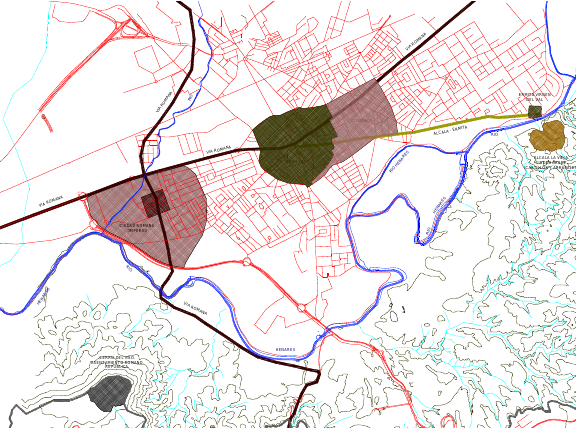
Figure 3. Plant of the University as described by Juan de Figure 1. Overlap of different core locations on the current Ovando in 1564. ( drawn en 1768, A.H.N) (Roman, 1994) plane of Alcalá